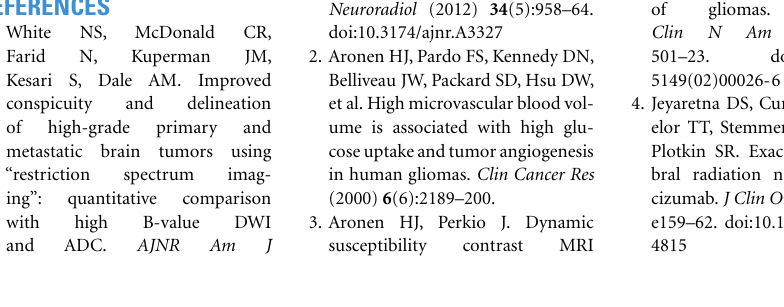
FIGURE 4 | (A,B) Coagulative necrosis and negative Ki-67 stain. (A) Shows two H&E stains from the grossly necrotic region; the first demonstrates coagulative necrosis with a hyalinized fibrotic blood vessel in the center and